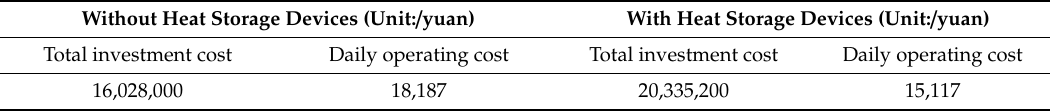
Table 4. The investment and operation cost of the regional integrated energy system under two scenarios. Without Heat Storage Devices (Unit:/yuan) With Heat Storage Devices (Unit:/yuan) Total investment cost